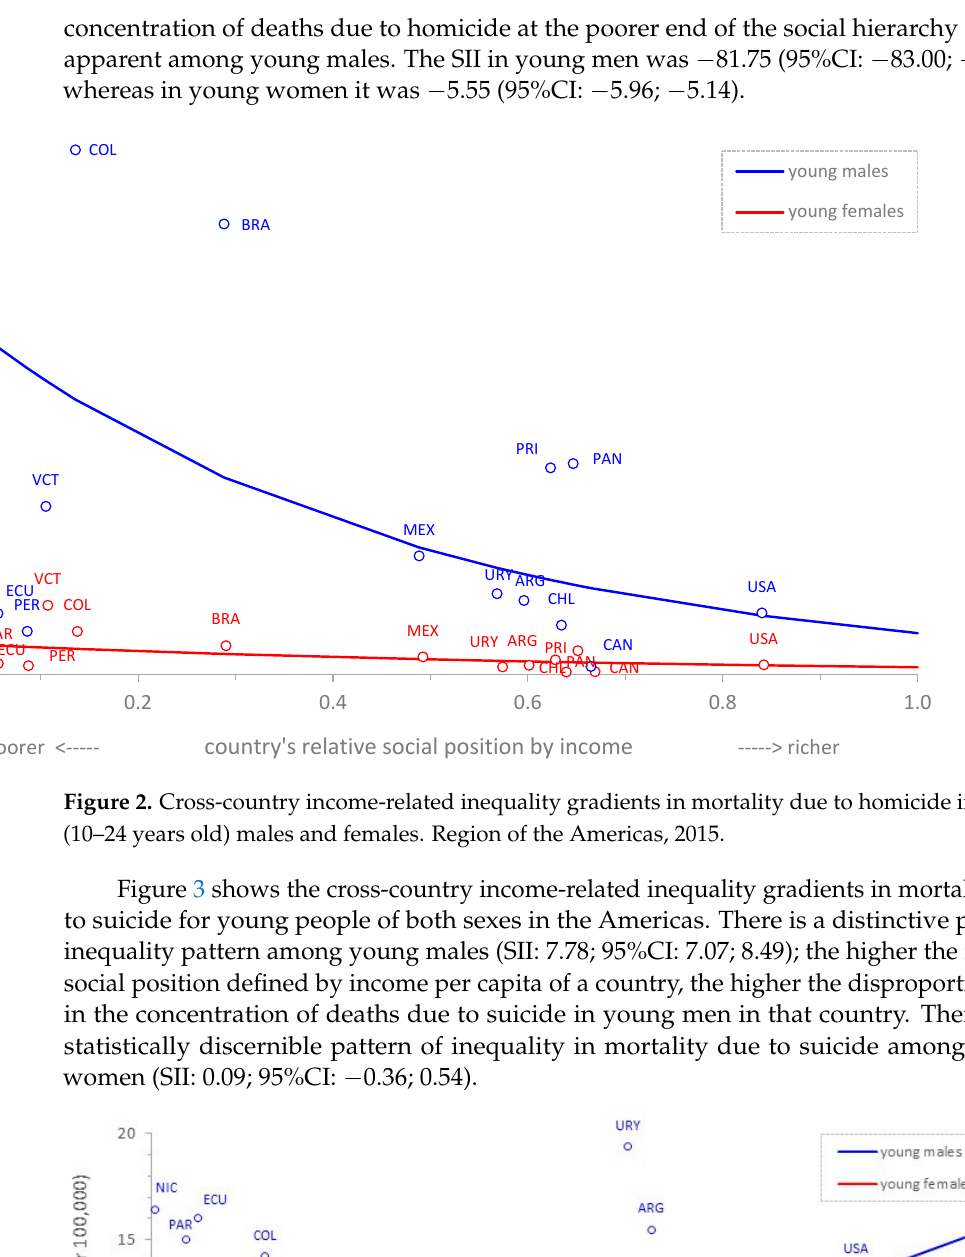
Figure 3. Cross-country income-related inequality gradients in mortality due to suicide in young (10–24 years old) males and females. Region of the Americas, 2015.